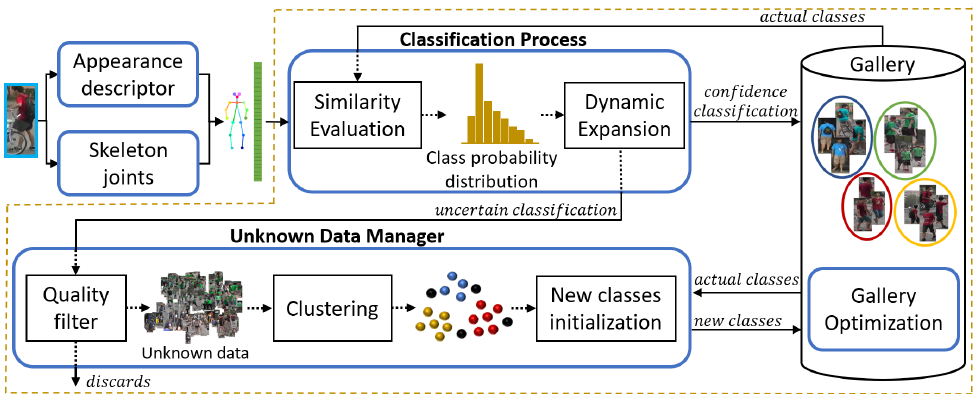
Figure 2. Self-adaptive gallery construction method overview. The person bounding box undergoes a pre-processing where the sample features are obtained with existing deep neural network encoders. Then, the proposed method analyzes the features obtained to decide which ones are used to adapt and evolve the gallery with the new